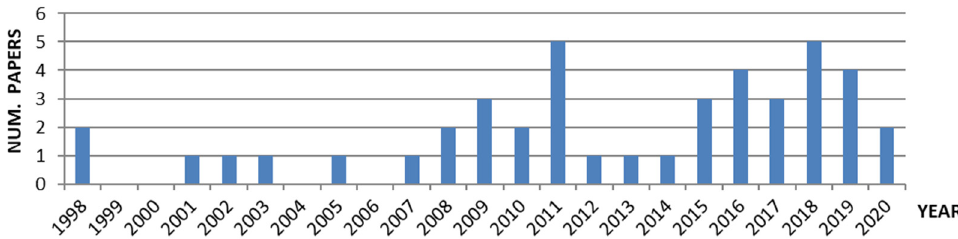
Figure 1. Selected papers organized by year of publication.